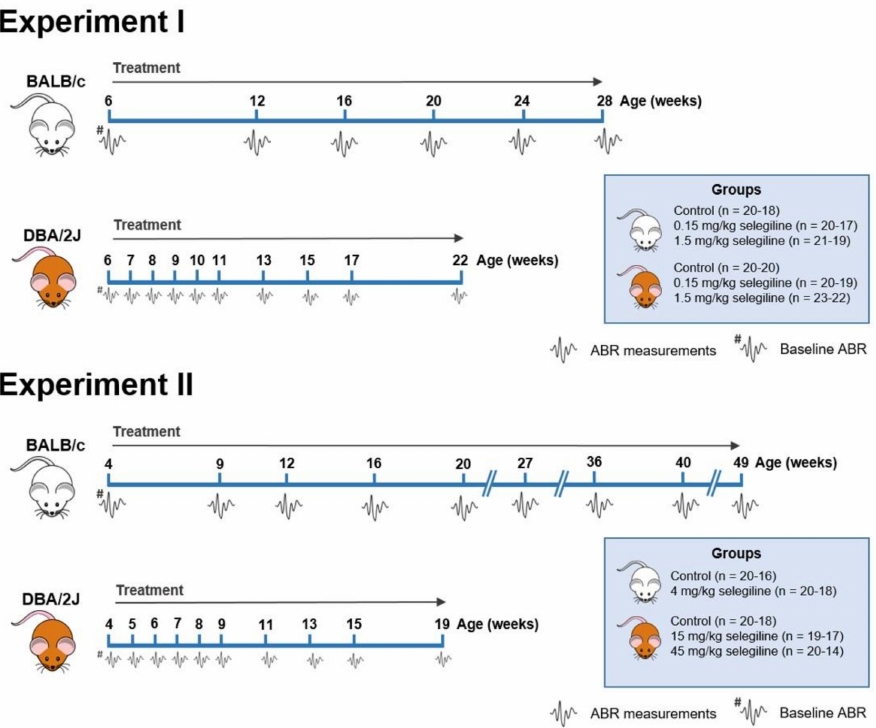
Figure 1. Flow chart showing the treatment protocol and time points of Auditory Brainstem Response (ABR) measurements in BALB/c and DBA/2J mice. Selegiline was dissolved in tap water and freely available for the mice throughout the entire experiment. The daily dose of selegiline was set to a given value (0.15, 1.5, 4, 15, and 45 mg/kg). ABR measurements are indicated by the tiny waveforms. The first ABR measurement (baseline hearing threshold) was performed one day before the onset of selegiline administration. The whole study was carried out in two subsets. The insets show the treatment groups. The number of mice at the start and at the end of the experiments is indicated in parentheses. Experiment I. 0.15 and 1.5 mg/kg selegiline were administered to both BALB/c and DBA/2J mice. The control group received tap water, the solvent of selegiline. In the case of DBA/2J period. Experiment II. 4 mg/kg of selegiline was administered to BALB/c mice, and 15 and 45